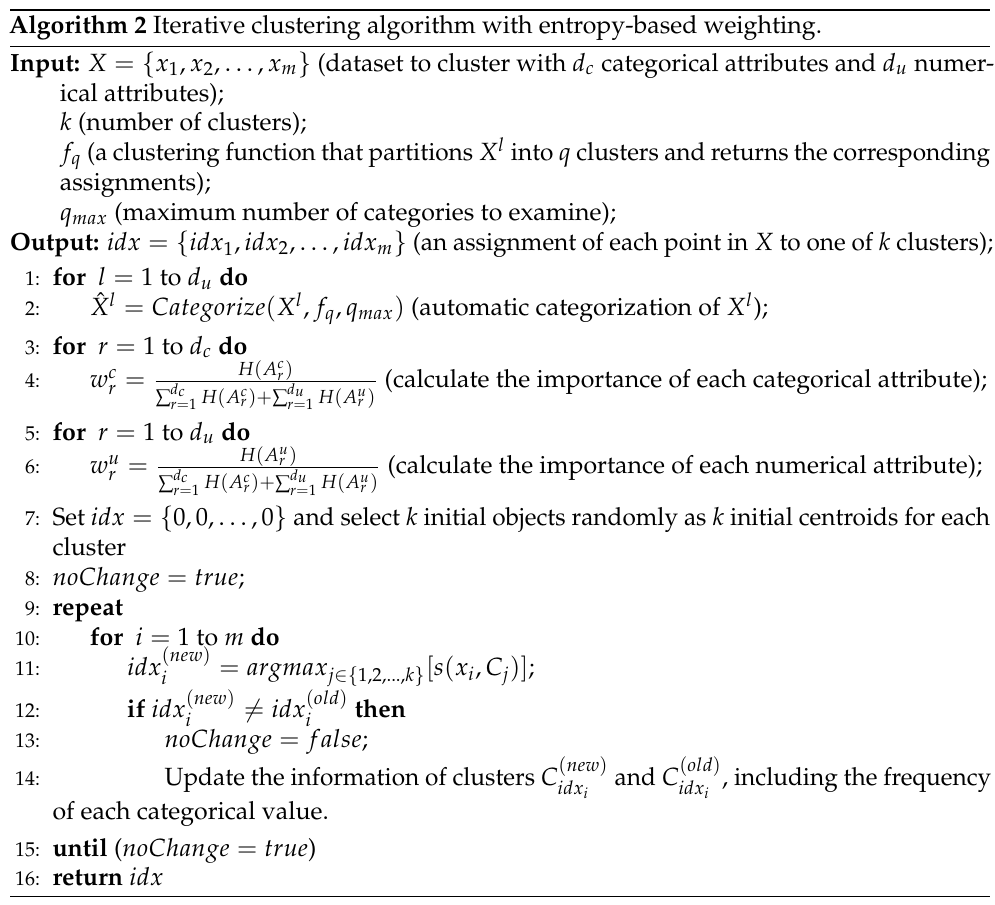
Algorithm 2 Iterative clustering algorithm with entropy-based